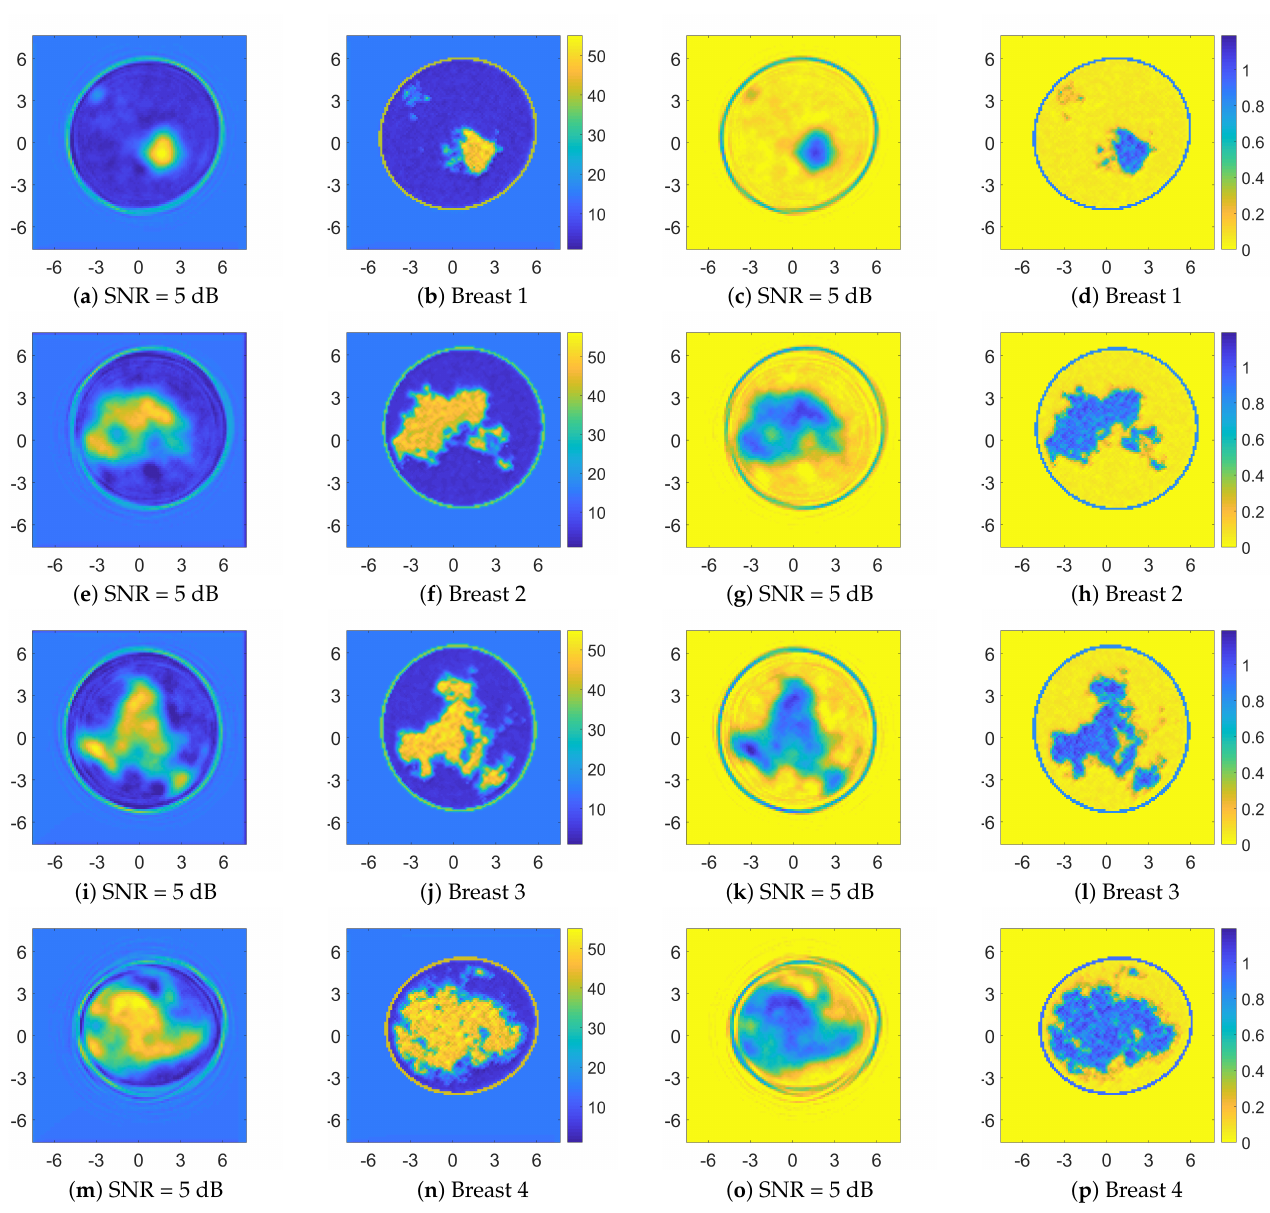
and also allows good enough resolution of the skin layer and a fast inversion